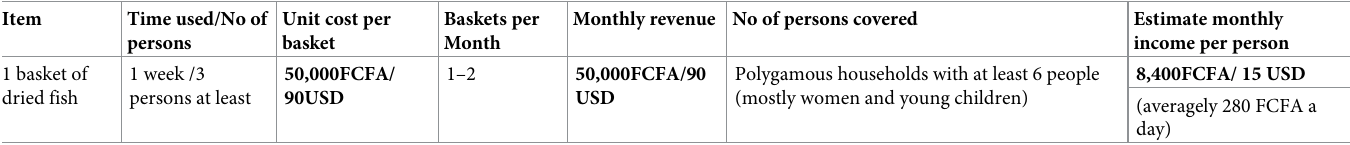
Table 5. Revenue table for fish sale (with 1USD at 550